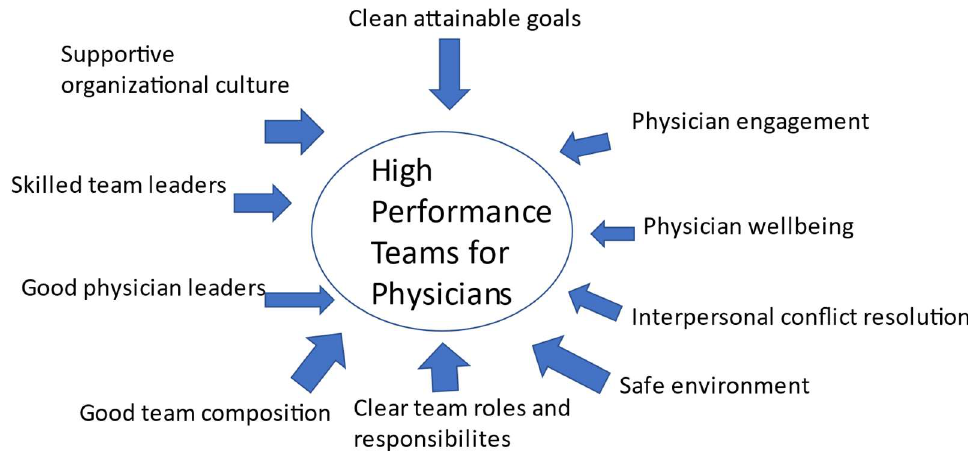
Figure 3. The critical dimensions for creating a high-performance team with physicians, in health care organizations.